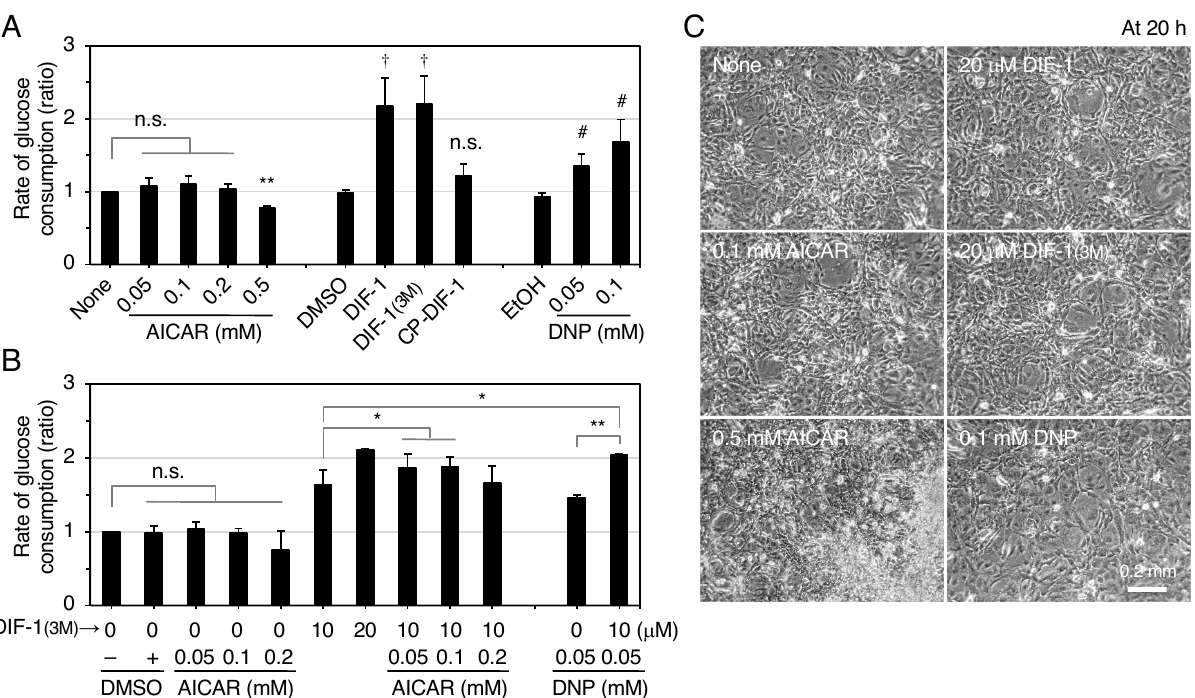
Figure 4. Effects of DIF derivatives on glucose consumption in confluent 3T3-L1 cells. ( A ) Cells were incubated for 15–20 h in the presence or absence of 0.2% DMSO or EtOH (vehicles), 20 µ M DIF derivatives or the indicated concentrations of AICAR and DNP. The glucose concentration in each medium was measured, and the rate of glucose consumption was calculated. The mean values and SD of the three independent experiments are presented. ** p < 0.01, † p < 0.05, # p < 0.05 versus control; n.s., not significant. ( B ) Cells were incubated for 15–20 h in the presence of the indicated additives and the combined effects of DIF-1(3M) and AICAR or DNP on glucose consumption were also assessed as in ( A ). The mean values and SD of the four independent experiments are presented. * p < 0.05, ** p < 0.01; n.s., not significant. ( C ) Cells were incubated for 20 h in the presence or absence of the indicated concentrations of the additives and observed by a phase-contrast